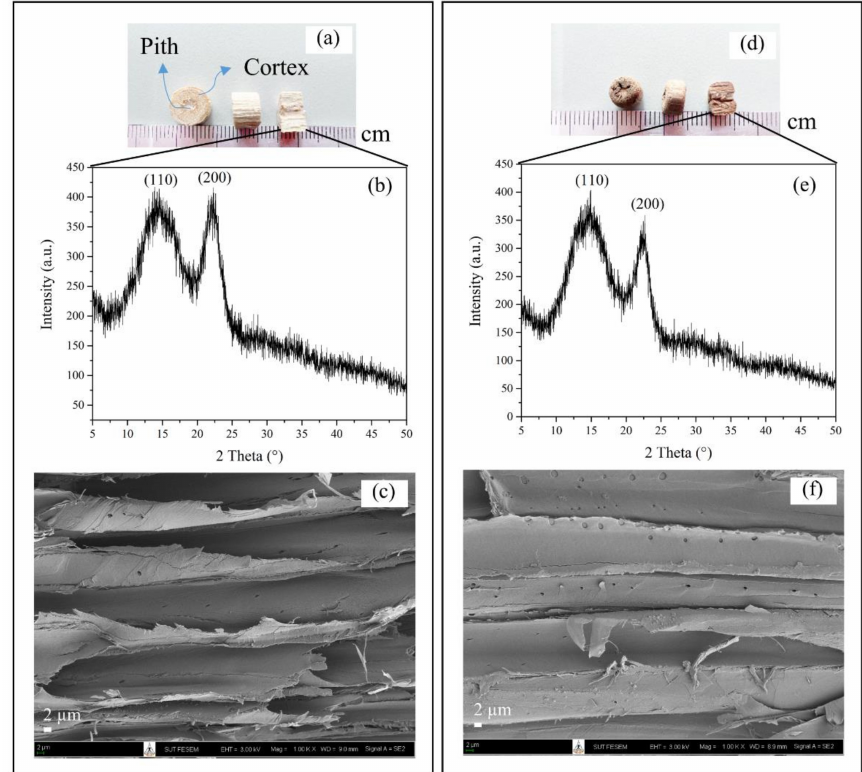
Figure 1. ( a ) Photographs of untreated Lead tree wood (LW) pellets, from left to right showing the pith and cortex from the top view, the side view and cross section; ( b , c ) XRD pattern and SEM image of the LW cross section; ( d ) photographs of refluxed LW pellets, from left to right showing the top view, the side view and cross section; ( e , f ) XRD pattern and SEM image of the refluxed LW cross section.